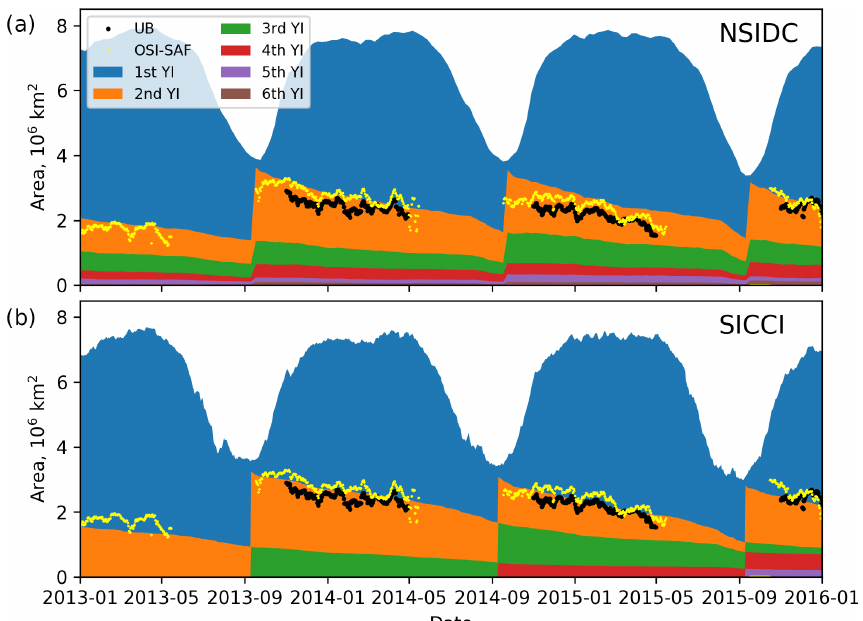
Figure 8. Seasonal dynamics of area of sea ice age fractions (filled plots) and multi-year ice area (dots) derived from the NSIDC product (a) , from the SICCI product (b) , from the UB product (black dots) and from the OSI SAF (yellow